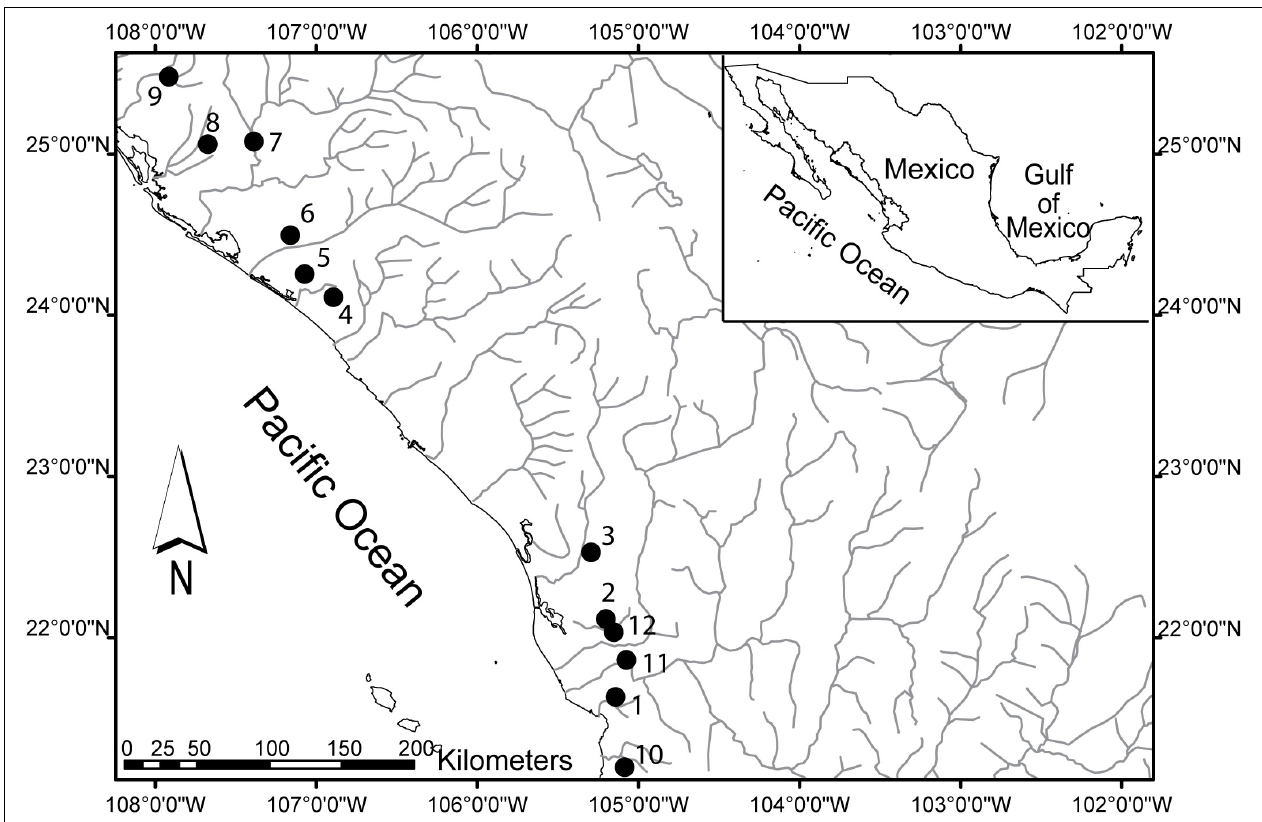
FIGURE 1 | Map showing the localities sampled for Poeciliopsis prolifica. Inset map shows Mexico and the two states (Nayarit and Sinaloa) that were sampled. Numbers correspond to location ID (also found in Table 2